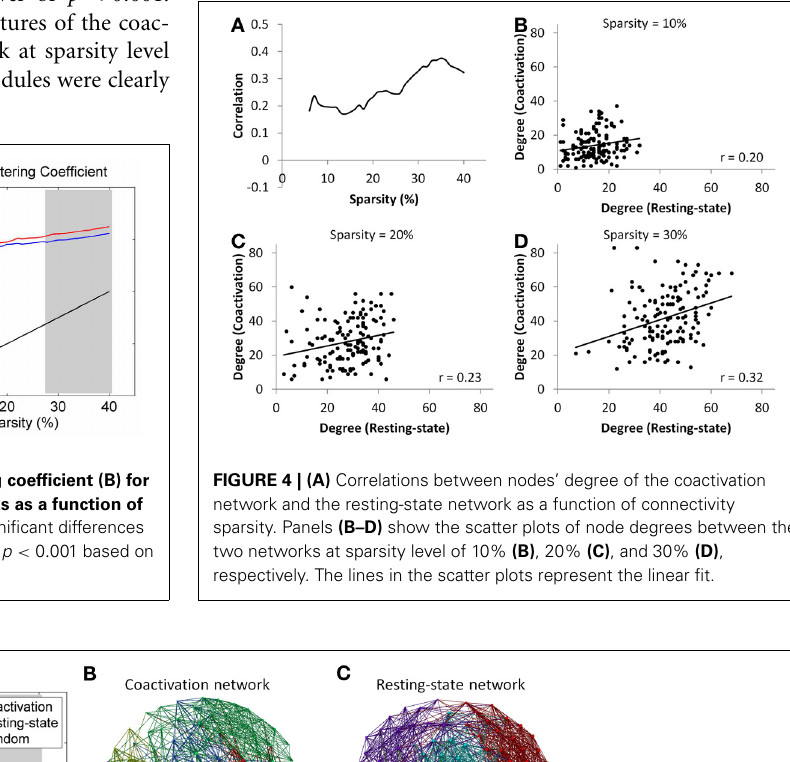
permutations. Panels (B,C) demonstrate the modular structures for the coactivation network and the resting-state network at sparsity level 20%. The node colors in panels B and C encode different